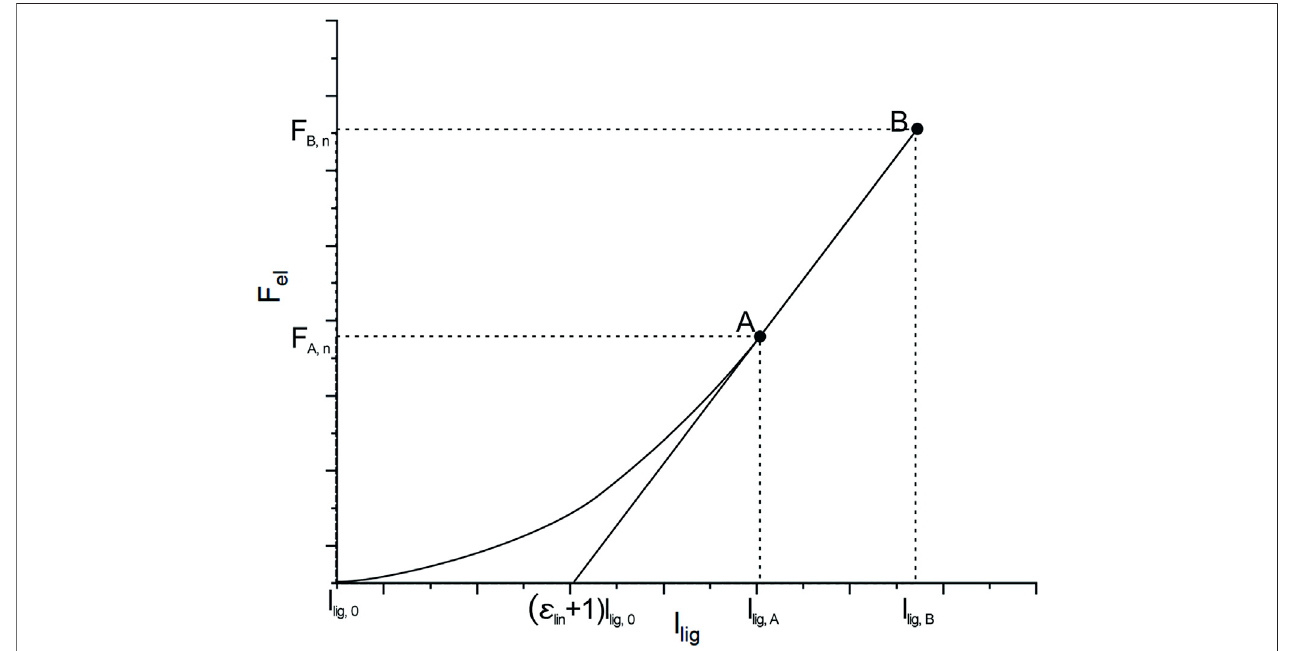
FIGURE4| Typical force – length curve todescribe the mechanical behaviorofligaments.Transition from nonlinear tolinear regions are de fi ned by l A and F A and F B and l B marks the maximum force and elongation before failure